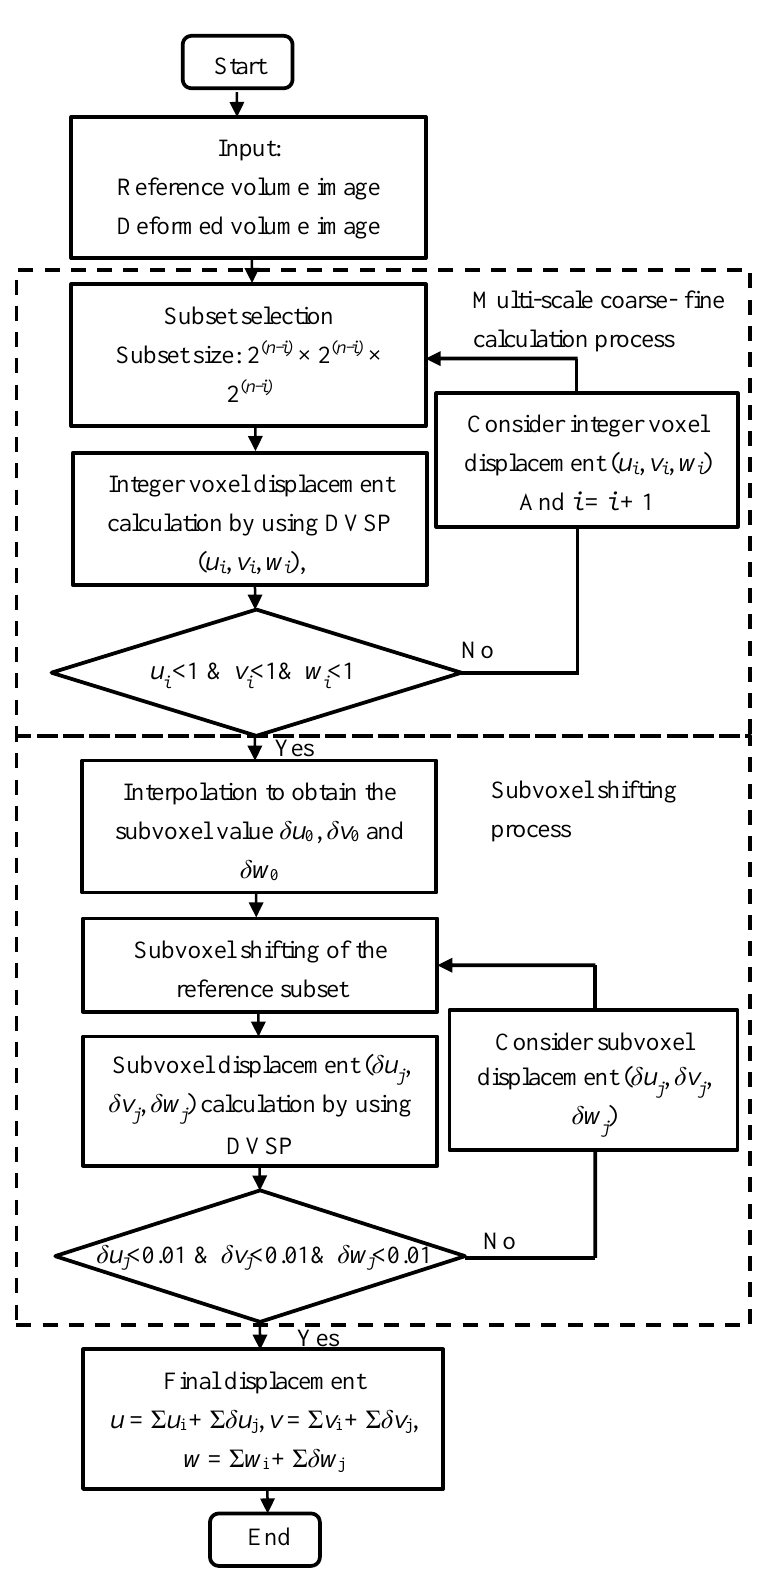
Figure 1. Flowchart of the (Multi-scale and Subvoxel shifting Digital Volumetric Speckle Photography) MS-DVSP algorithm.